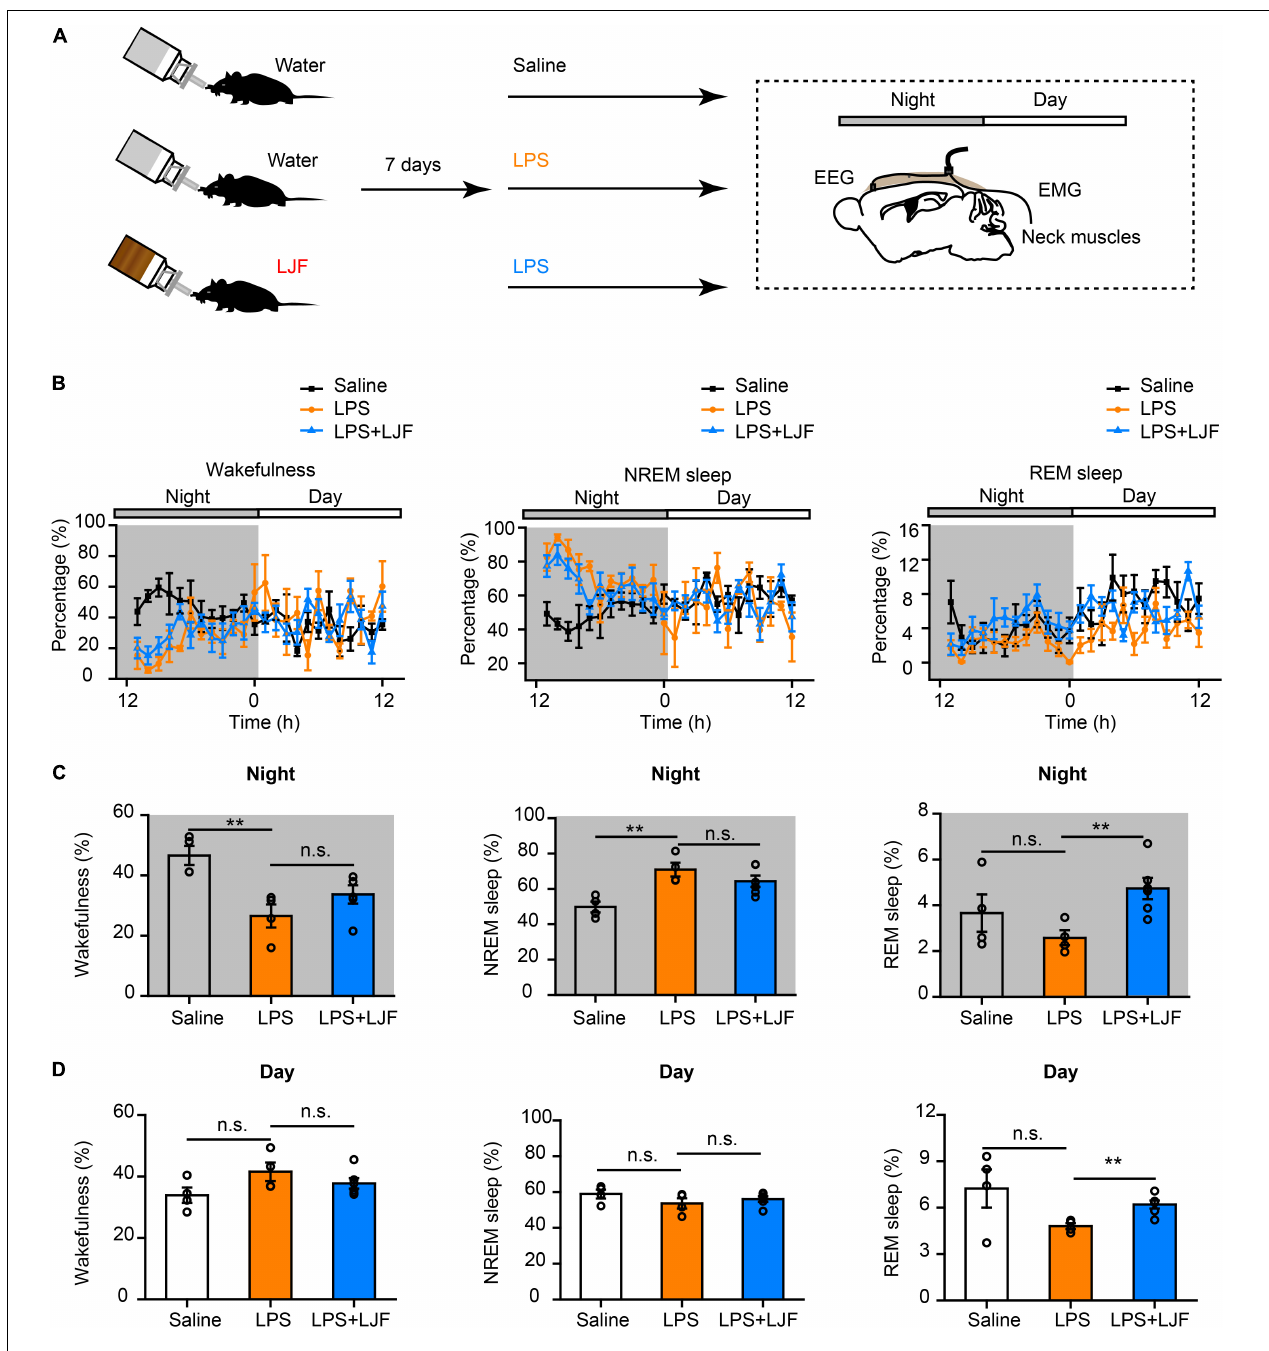
FIGURE 5 | Lonicerae Japonicae Flos (LJF) promotes sleep in the LPS- challenged mice. (A) The scheme of sleep recordings after LPS administration in the control and LJF-treated mice. (B) Time spent in wakefulness (left), NREM sleep (middle), and REM sleep (right) by the saline ( n = 4), LPS ( n = 4), and LPS + LJF ( n = 6) groups of mice. (C,D) Histogram plots show the time spent in wakefulness (left), NREM sleep (middle), and REM sleep (right) during (C) night and (D) day by the saline ( n = 4), LPS ( n = 4), and LPS + LJF ( n = 6) groups of mice. Each dot represents one mouse. Data are expressed as means ± S.E.M. The differences between groups were assessed by one-way ANOVA followed by LSD post-hoc test. ** P < 0.01; n.s., no